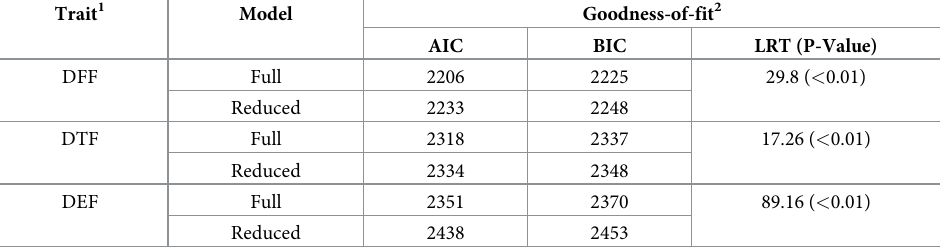
Table 2. Goodness-of-fit measures for models with (Full) and without (Reduced) genotype-by-environmental interaction. Trait